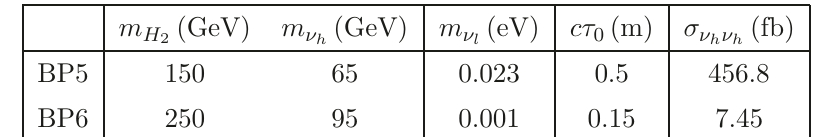
Table 1. Definition of the BPs leading to DVs from the heavy neutrinos produced by the SM-like Higgs decay. From left to right, the columns display the values of heavy RH neutrino mass, light neutrino mass, proper decay length of the heavy neutrinos and production rate of heavy neutrino pairs coming from the decay of the SM-like Higgs produced via gluon fusion.